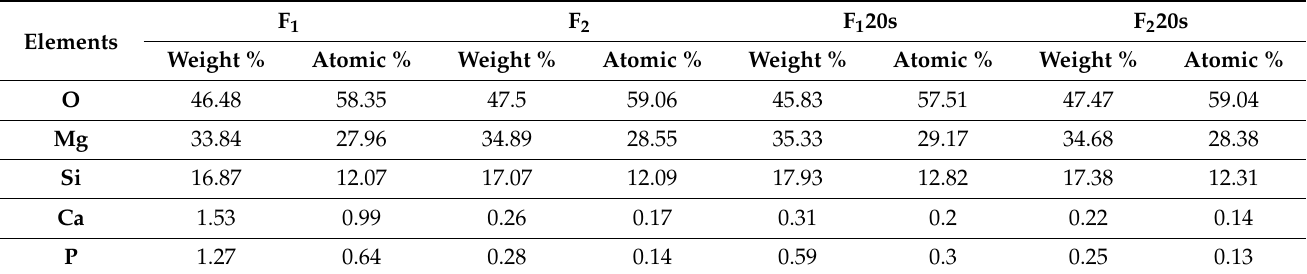
Table 2. Chemical composition of samples after 14 days in SBF.